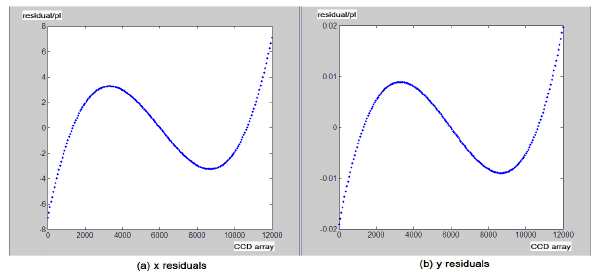
Figure 3. Residuals of IO estimation from provided view